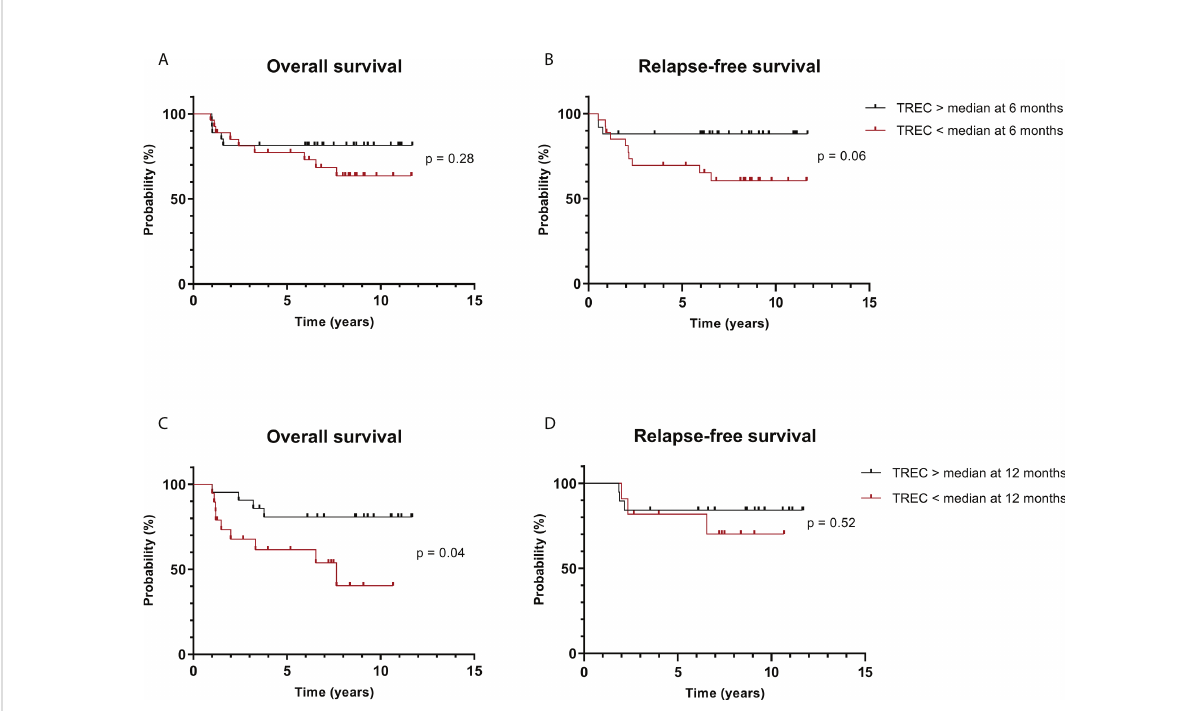
FIGURE 3 Patients with higher TREC levels have superior overall survival. Patients were divided into groups according to TREC level above or below the median in samples taken at (A, B) 6 months post-HSCT; (C, D) 12 months post-HSCT. Kaplan-Meier plots with p-value from log-rank test.